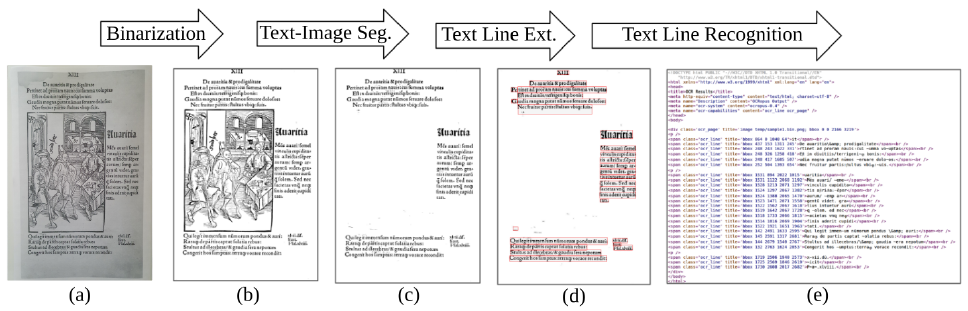
Figure 1. The anyOCR system processing pipeline: ( a ) input image, ( b ) after Binarization, ( c ) after Text and Image Segmentation, ( d ) after Text Line Extraction, and ( e ) after Text Line